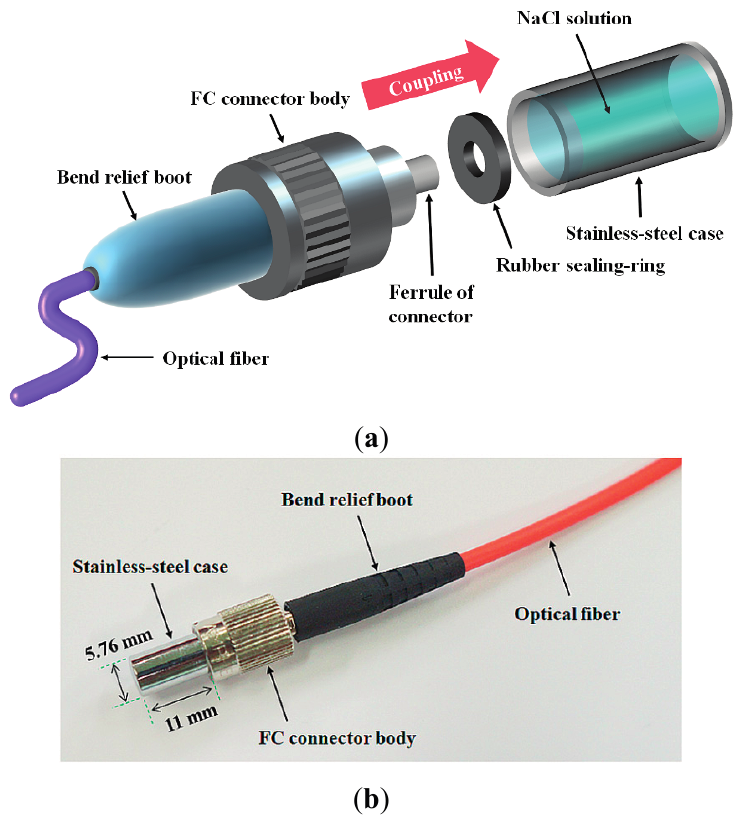
Figure 2. ( a ) Internal structure and ( b ) photograph of the sensing